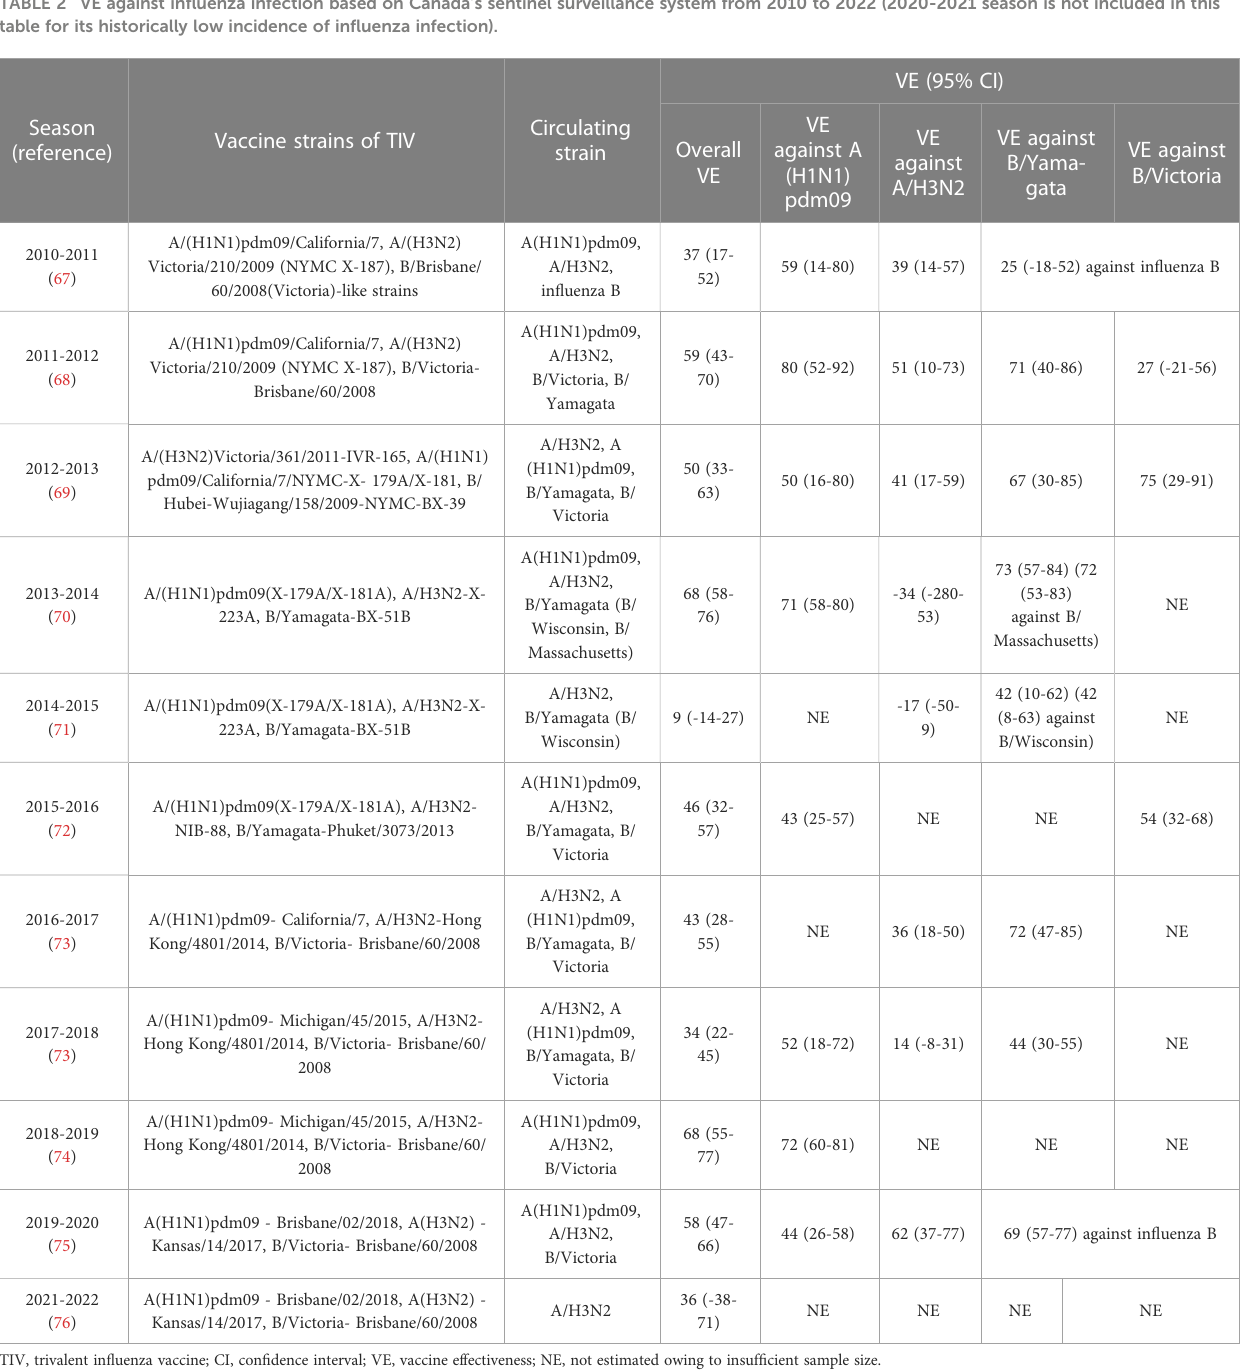
TABLE 2 VE against in fl uenza infection based on Canada ’ s sentinel surveillance system from 2010 to 2022 (2020-2021 season is not included in this table for its historically low incidence of in fl uenza infection).